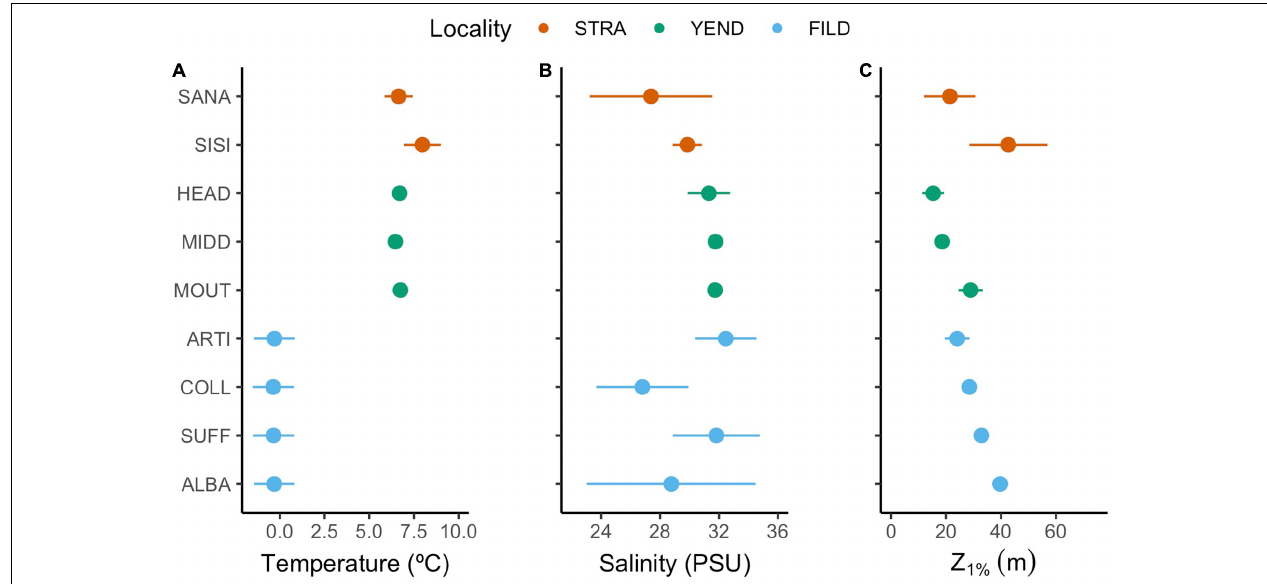
FIGURE 2 | Site-scale environmental variables analysed in this study. Temperature (A) , salinity (B) , and light penetration (C) were measured in situ at each site. Light (PAR) penetration in MIDD (C) was estimated once due to logistic constraints. Values are reported as means and standard deviations. Localities are Strait of Magellan (STRA), Yendegaia Fjord (YEND), and Fildes Bay (FILD).